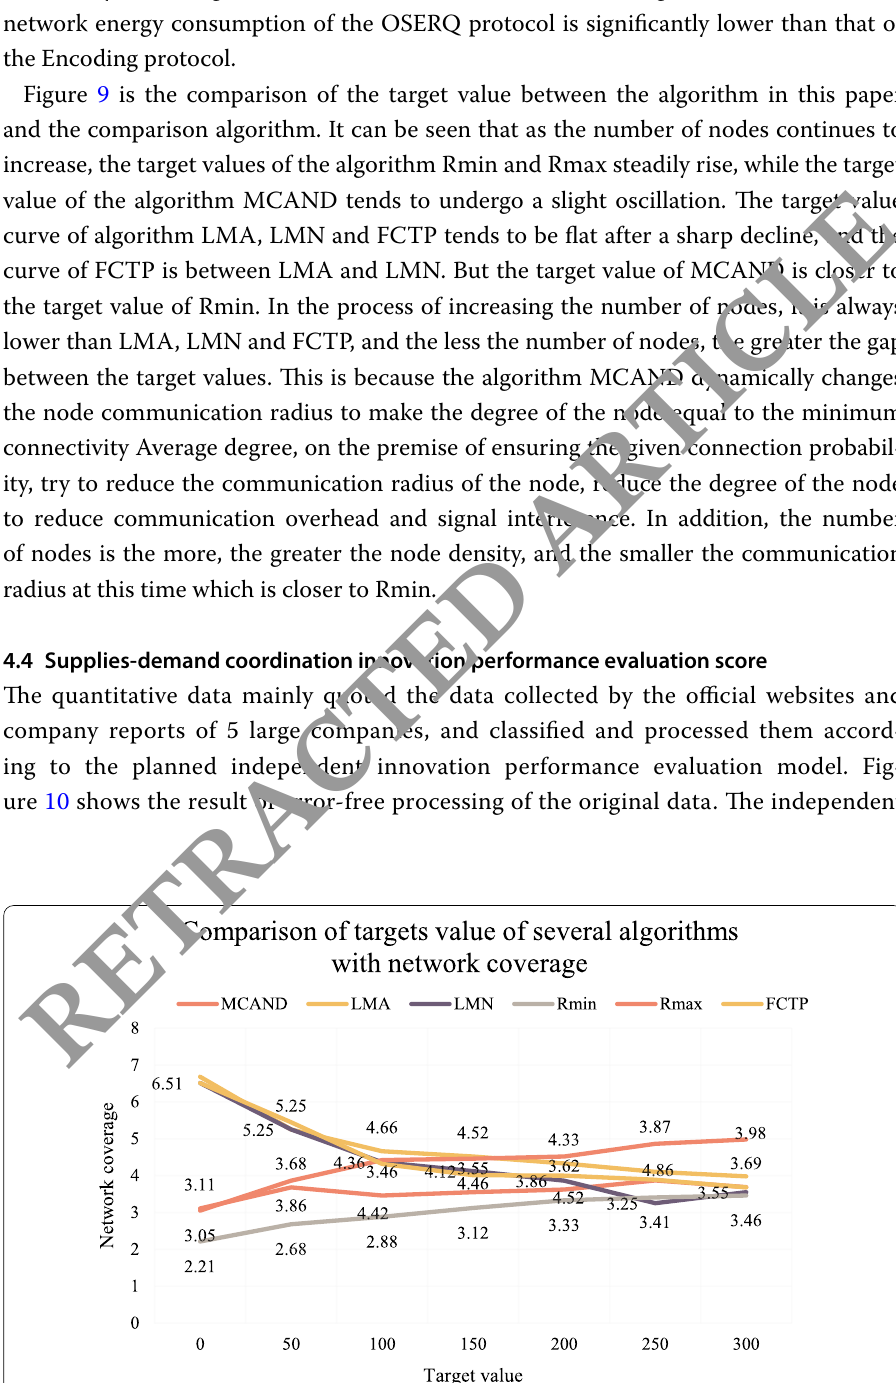
Fig. 9 Comparison of target values of several algorithms with network